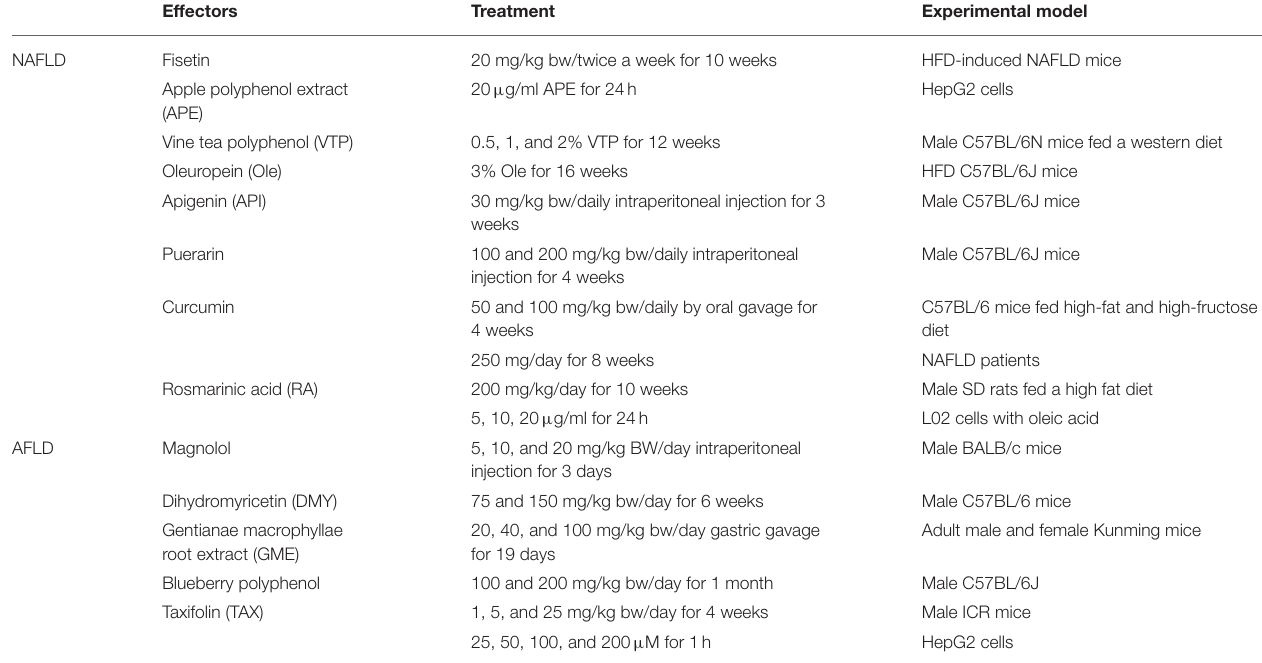
TABLE 1 | Potential effectors shown to protect the liver from NAFLD and